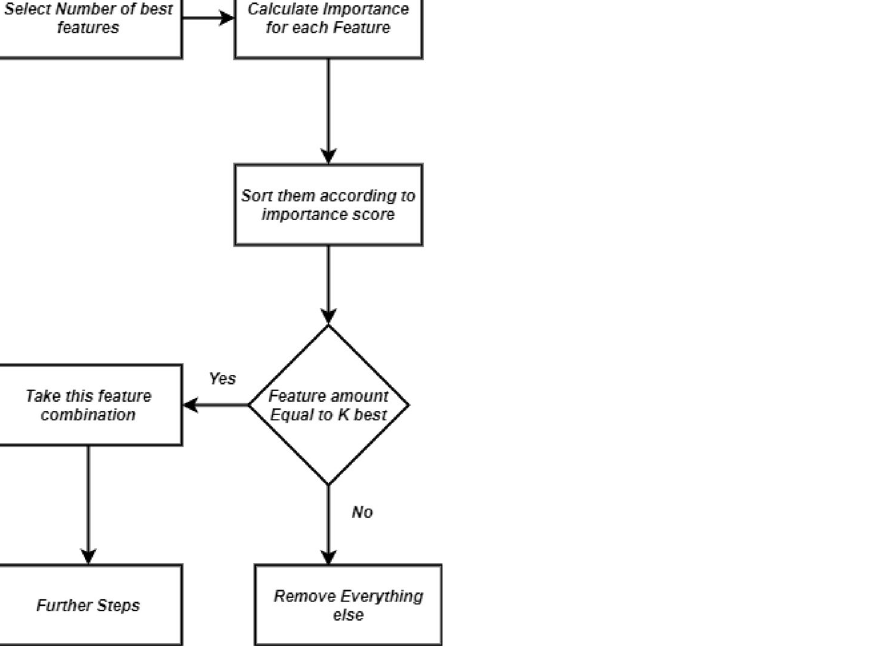
Figure 6. Procedure of feature selection using